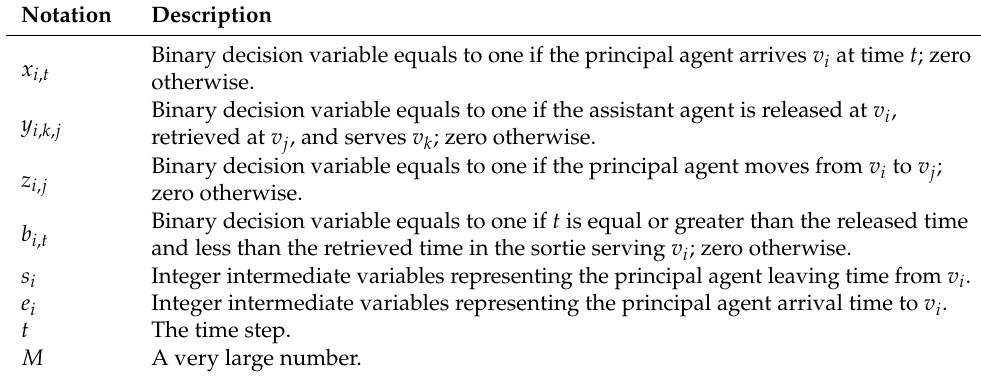
Table 1. Parameters and variables for the 1-principal-1-assistant